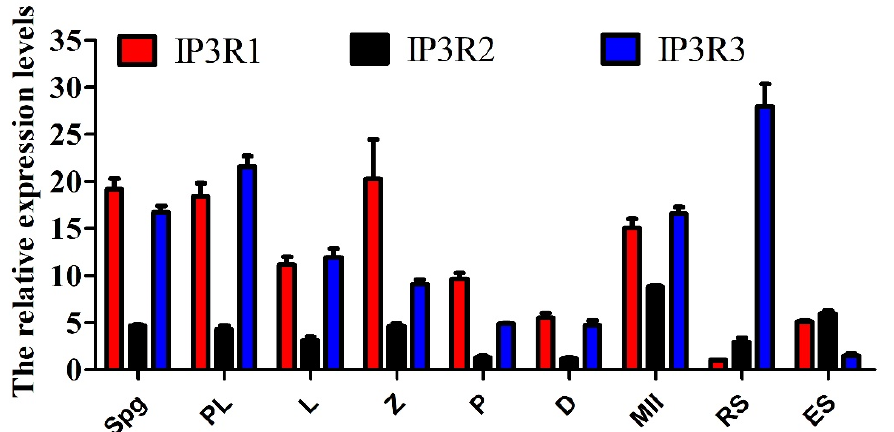
Figure 3. mRNA expression levels of inositol 1,4,5-trisphosphate receptors (IP3Rs) in mouse spermatogenic cells. Spermatogonia (Spg), preleptotene (PL), leptotene (L), zygotene (Z), pachytene (P), diplotene (D), secondary spermatocytes (MII), round spermatids (RSs), and elongated spermatids (ES) were sorted by flow cytometry with Hochest33342 / propidium staining. Total RNA was used to analyze mRNA expression levels of IP3R1, IP3R2 and IP3R3 by qPCR. β -actin served as an internal control to normalize the gene expression levels.